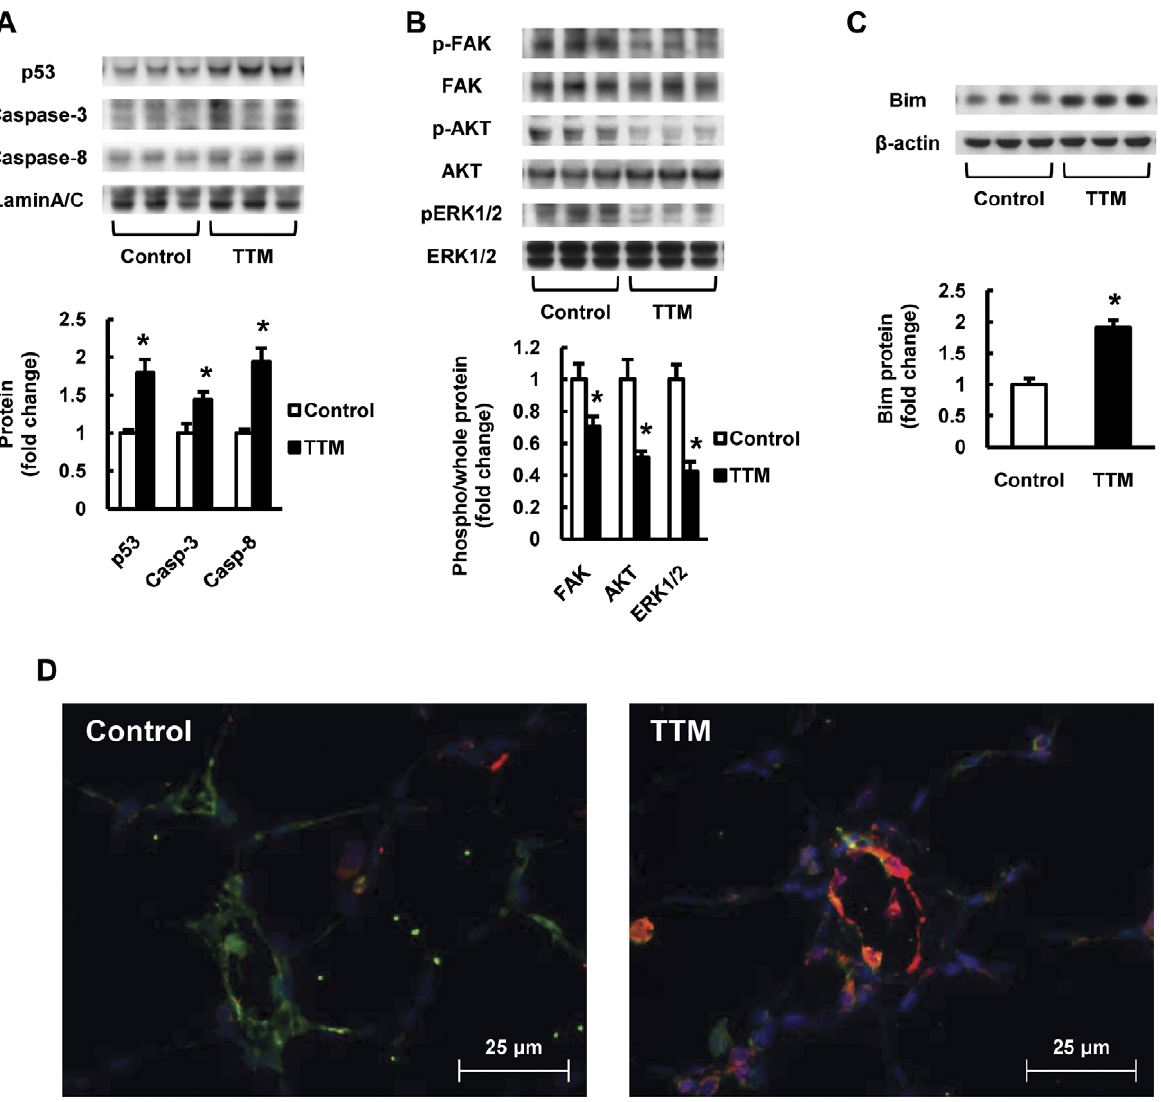
Figure 5. Copper depletion induces anoikis related proteins and inactivates focal adhesion kinase (FAK), AKT and ERK signaling in rat lungs. (A) Representative Western blot analysis of p53, caspase-3, caspase-8 and Lamin A/C in lung protein extracts from TTM treated rats. The bar graph shows the ratios of protein expression relative to Lamin A/C protein. (B) Representative Western blot analysis of phospho-FAK, FAK, phospho-AKT, AKT, phospho-ERK1/2 and ERK1/2 in lung protein extracts from TTM treated rats. The upper bar graph shows the ratios of phosphorylated protein expression relative to each whole protein expression. (C) Representative Western blot analysis of Bim and b -actin in lung protein extracts from TTM treated rats. The bar graph shows the ratios of protein expression relative to control. Data are expressed as mean 6 SE (n=6). *P , 0.05 versus control. (D) Dual staining for Bim (red) and von Willebrand factor (vWF) (green) shows that the Bim positive cells are identified in and around the small pulmonary arteries from copper depleted rat lungs. The blue color shows 4,6-Diamidino-2-phenylindole (DAPI)